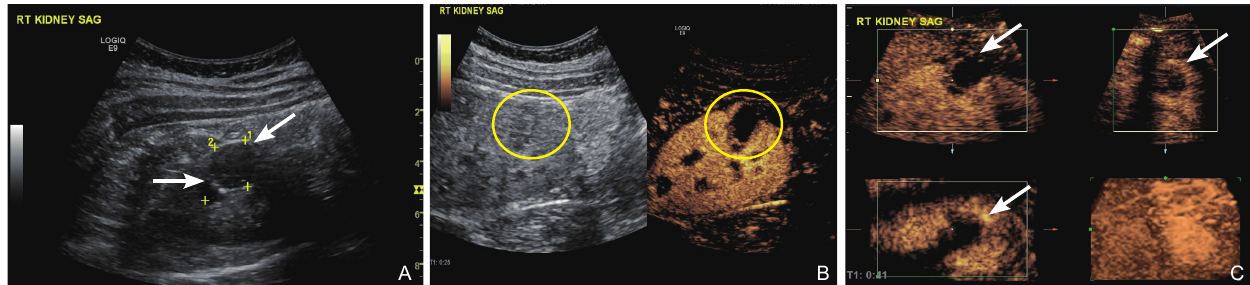
A Figure 7 Example of 2D and 3D CEUS of a Multilocular renal cyst. (A) Grey-scale ultrasound shows an anechoic multicystic mass with thin echogenic wall and septa (white arrows); (B) 2D dual imaging shows enhancement of wall and septation during the arterial phase (25 sec post-UCA injection); (C) Continuous CEUS 3D imaging was subsequently performed following a second bolus injection. The multilocular cyst is well visualized in three orthogonal planes (white arrows) and in the volumetric reconstruction (bottom right panel).